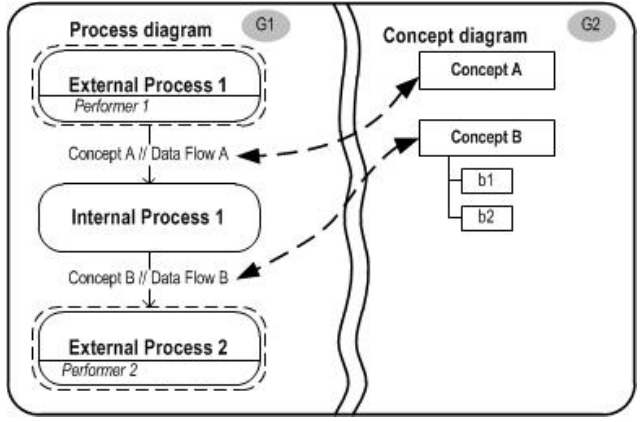
Fig. 2. Notation of the two-hemisphere